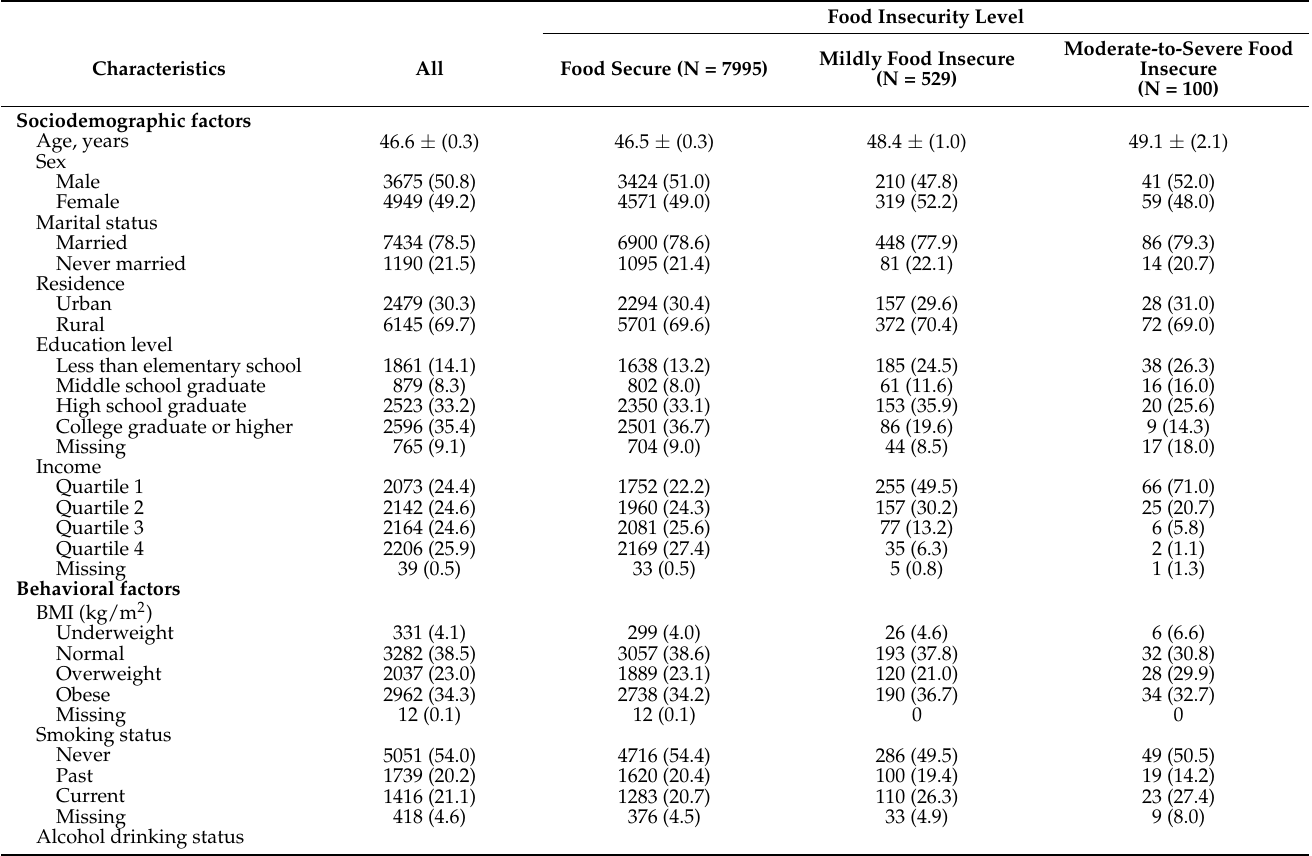
Table 1. Study population characteristics 1 (N =